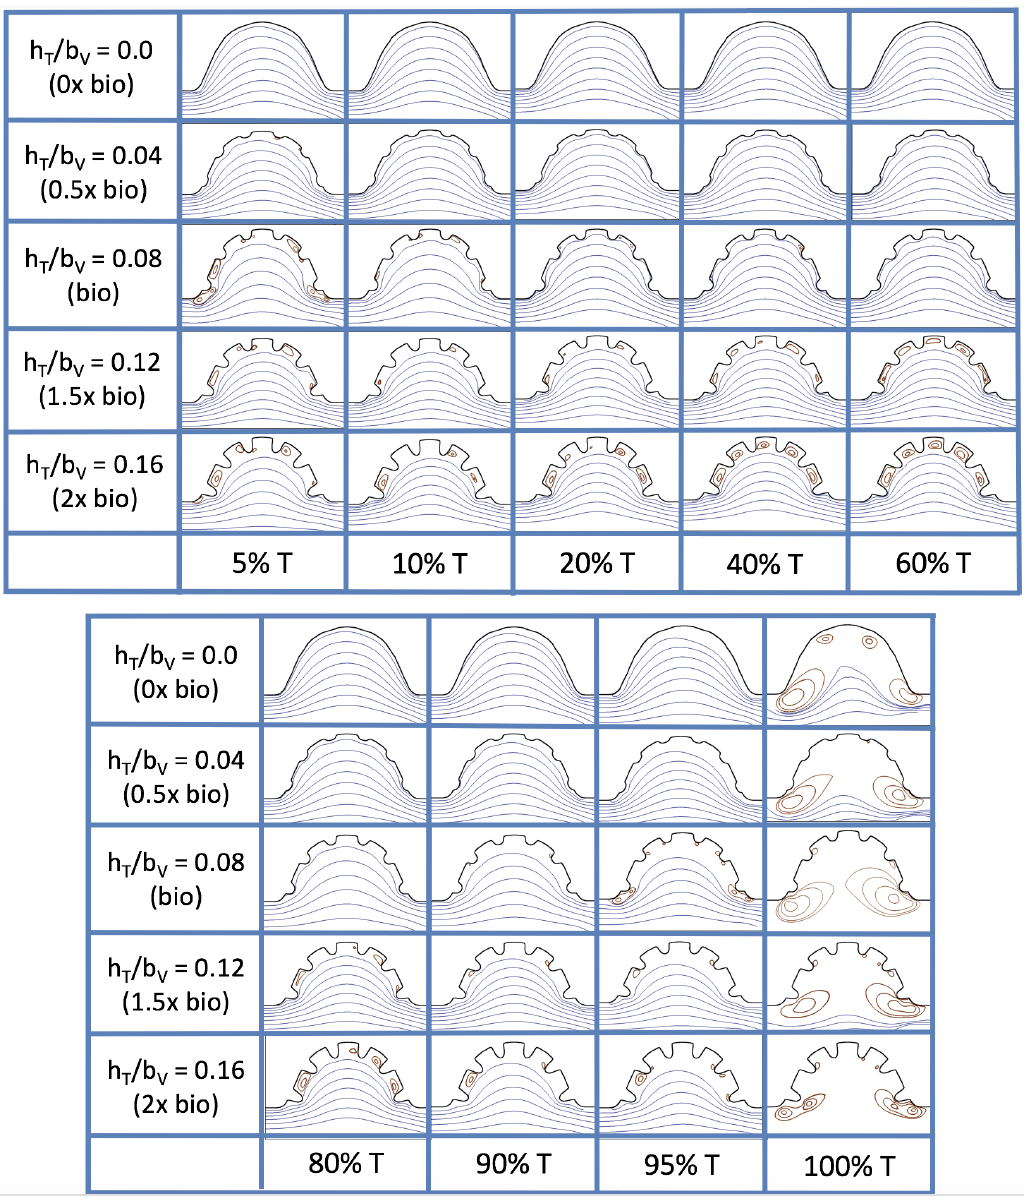
Figure 19. Streamline analysis taken at different time points within a single pulsation cycle (described by a percentage of a single pulsation period, T ) for the case of pulsatile flow into the trabeculated ventricle of a zebrafish at 4 dpf for Re = 0.1 and varying trabeculae